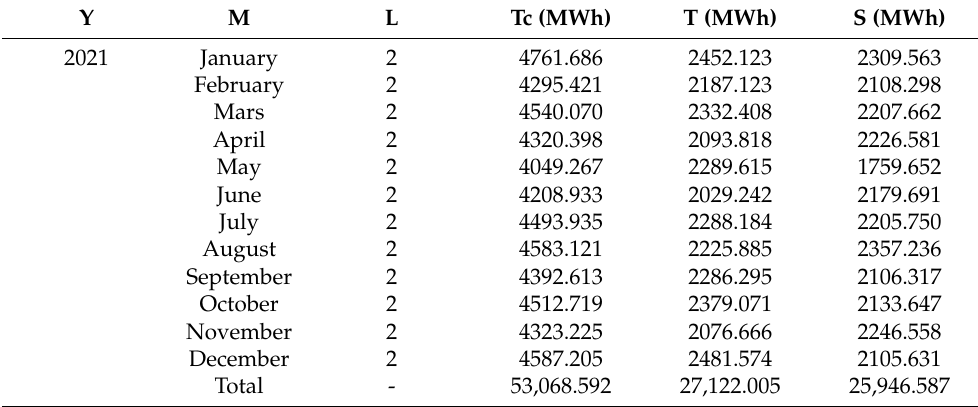
Table 1. The monthly minimal energy